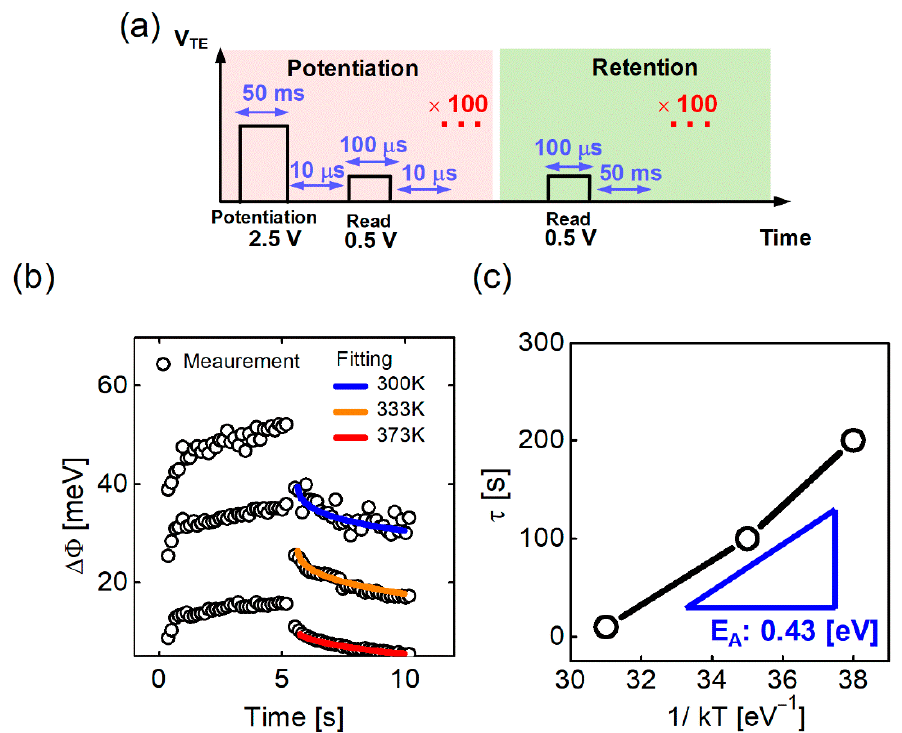
Figure 4. ( a ) Pulse schemes for potentiation and retention; ( b ) Barrier height changes with potenti- ation and retention pulses; and ( c ) 𝜏 vs. 1/kT curve for activation